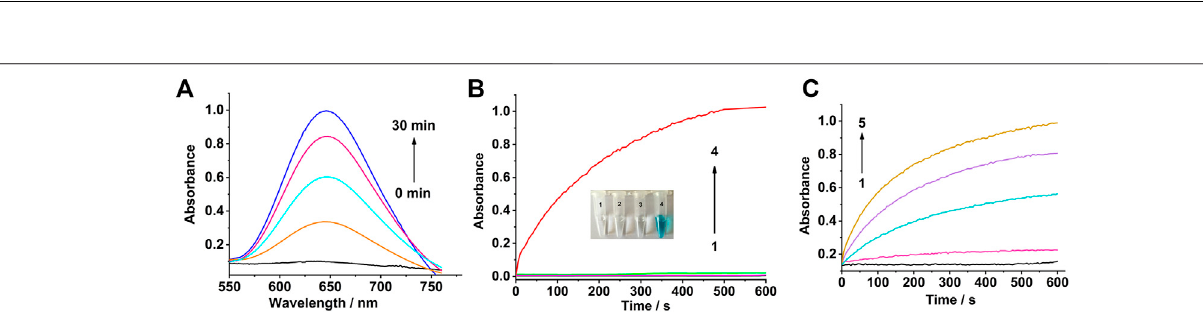
FIGURE1| SyntheticprocessandstructuralcharacterizationsofthelayeredCo 3 O 4 nanosheets (A) IllustrationforthehydrothermalsynthesisofthelayeredCo 3 O 4 nanosheets; (B) XRD pattern; (C) FT-IR spectrum; (D) SEM; and (E) TEM image of the as-prepared Co 3 O 4 nanosheets.